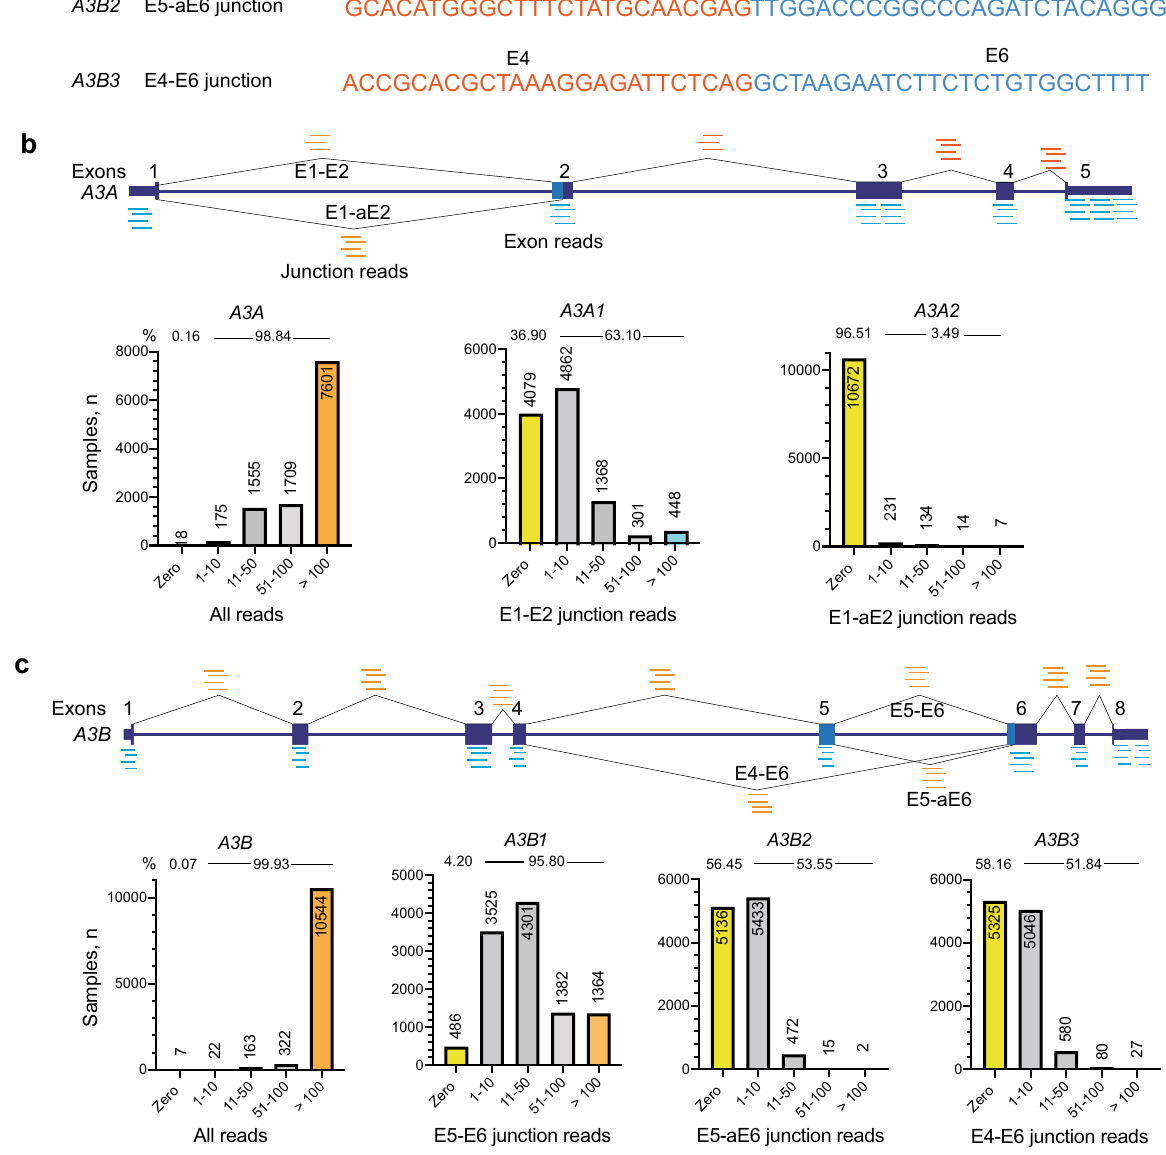
Fig. 1 Quanti fi cation of A3A and A3B expression based on the total and exon – exon junction RNA-seq reads in 11,058 TCGA samples. a Nucleotide sequences of exon – exon junctions speci fi c to A3A and A3B isoforms. “ X ” – mismatch between A3A and A3B sequences. b Schematics of A3A exons and splicing junctions. The bar graphs show the numbers of samples ( y axis) in relation to RNA-seq read counts grouped in 5 sub-categories ( x axis) for the total A3A expression and exon – exon junction-based expression of A3A1 and A3A2 isoforms. ‘ E ’ refers to exon and ‘ aE ’ refers to an alternative exon. Based on exon junction reads ( ≥ 1 read/sample), A3A1 (E1 – E2 junction) and A3A2 (E1-aE2 junction) is expressed in 6979 (63.10%) and 386 (3.49%) TCGA samples, respectively. c Schematics of A3B exons and splicing junctions and comparison of gene expression based on the total and exon – exon junction reads corresponding to A3B isoforms. A3B1 is expressed in 10,572 (95.8%) TCGA samples, but A3B2 and A3B3 are expressed in 53.55% (5922 of 11,058) and 51.84% (5733 of 11,058) of TCGA samples, respectively. The TCGA RNA-seq set includes 10,328 tumors and 730 adjacent normal tissue